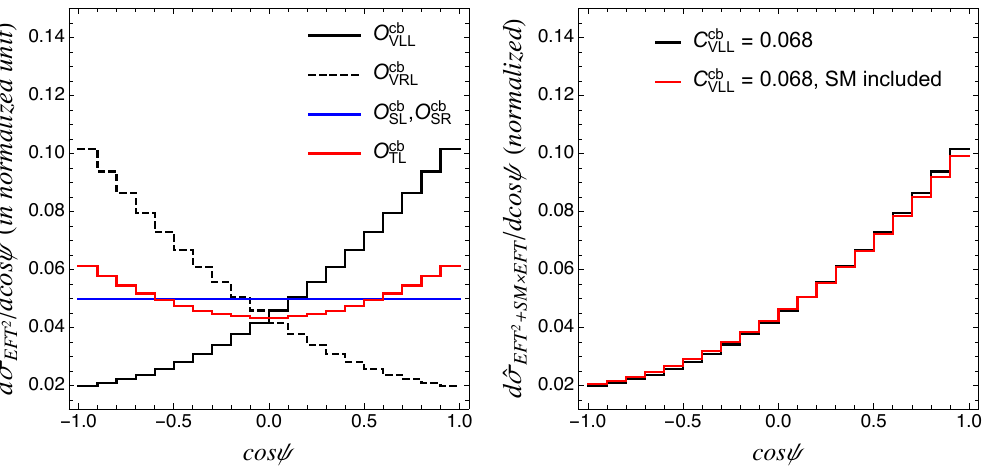
Figure 6 . Left: the normalized partonic differential cross section, d ˆ σ /d cos ψ , for an individual EFT 2 EFT coefficient by switching on each coefficient at a time. Right: similarly for the O cb operator V LL with the best-fit value C cb | best-fit = 0 . 068 including the SM contribution. In both plots, the √ V LL energy of the system is fixed to be ˆ s = 1 TeV and p T ( b ) ≥ 20 GeV was